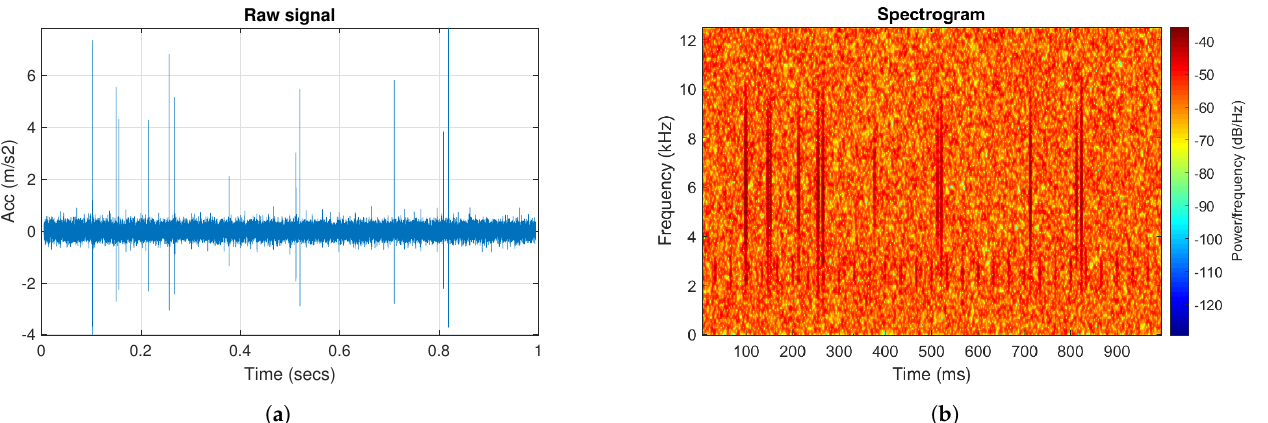
Figure 3. ( a ) Simulated signal s 1 with the amplitude of the non-cyclic impulses set to 8.5. ( b ) Spectrogram of simulated signal s 1